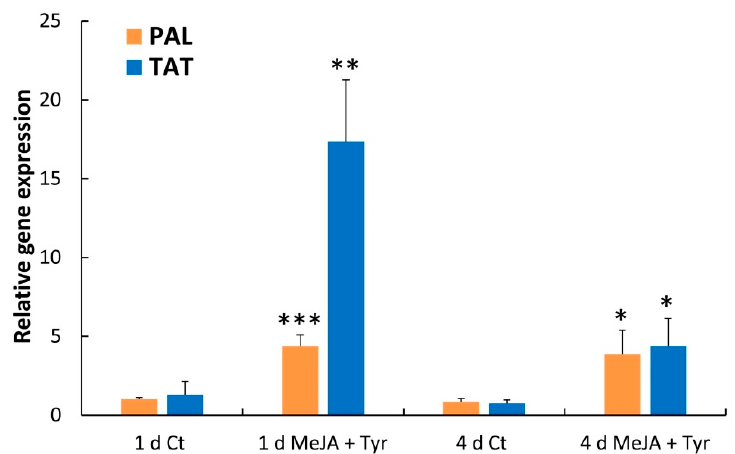
Figure 8. Expression analysis of the PAL and TAT genes from hemp cell suspensions after 1 and 4